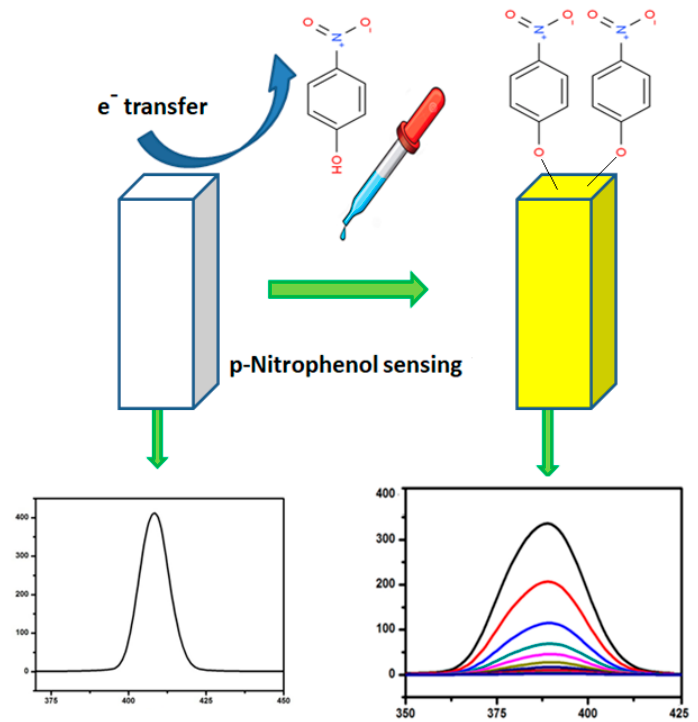
Figure S1: EDS of pure ZnO nanoparticle, Figure S2: EDS of 1% Ag-ZnO nanoparticle, Figure S3: EDS of 5% Ag-ZnO nanoparticle, Figure S4. EDS of 10% Ag-ZnO nanoparticle, Figure S5. Deconvoluted high-resolution XPS spectra for 1% Ag-ZnO powder